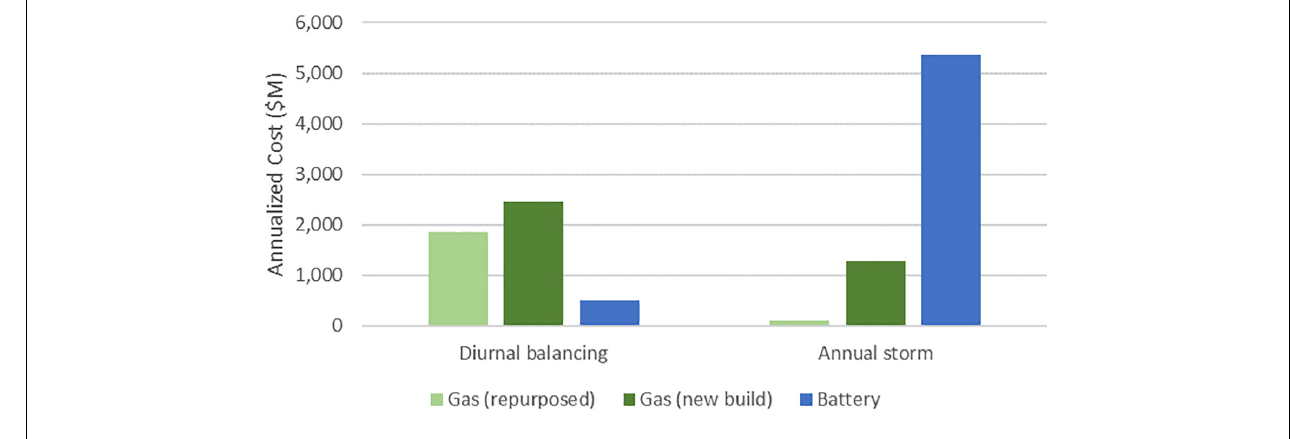
FIGURE 1 | Cost of balancing the electricity grid.